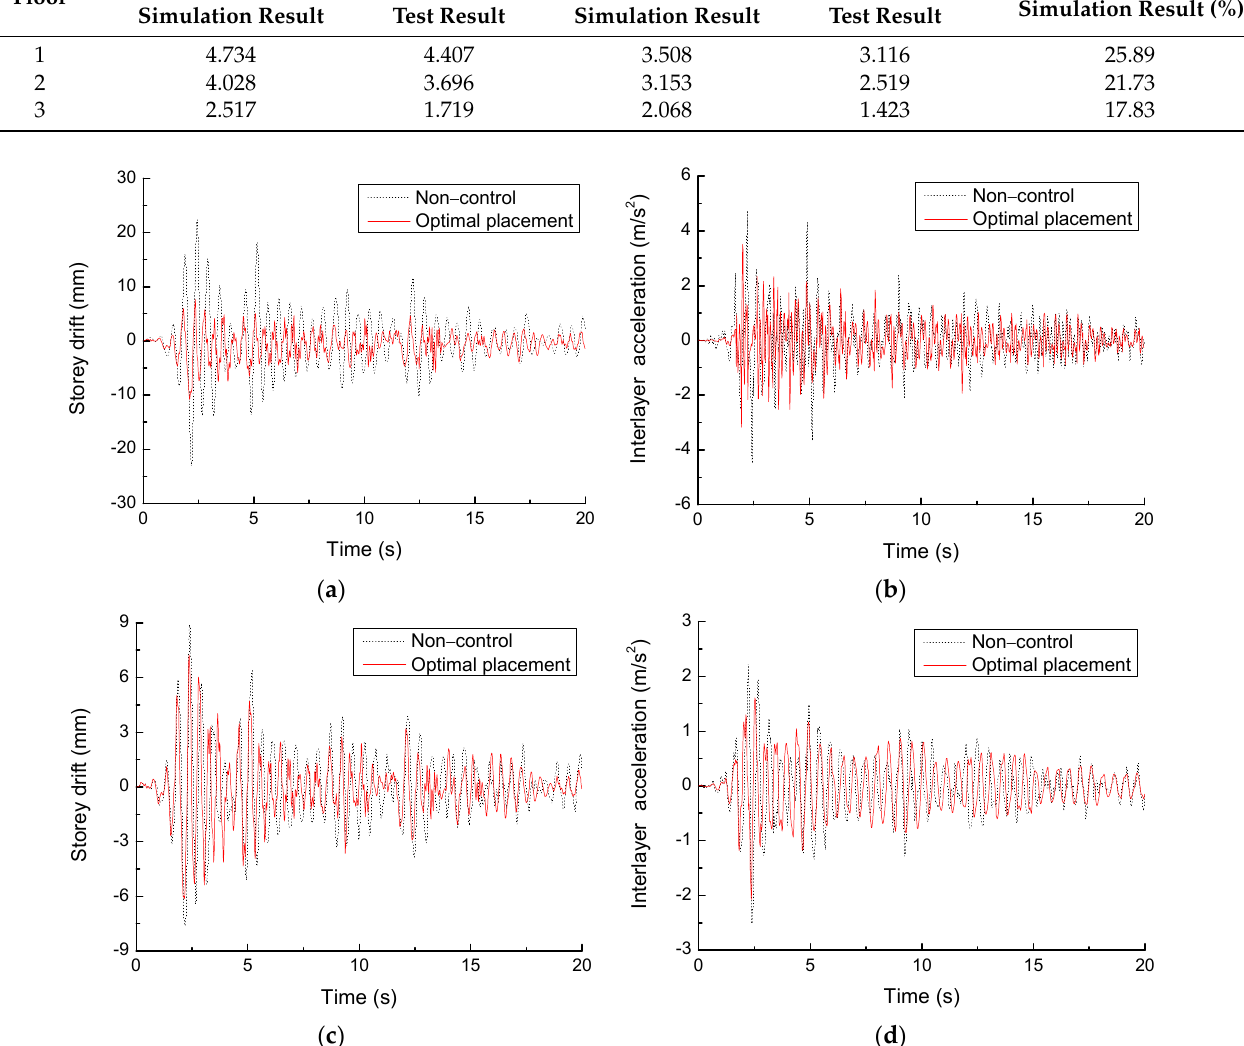
Figure 14. Time history curves of seismic response of spatial model structure with and without control, ( a ) storey drift of first floor, ( b ) interlayer acceleration of first floor, ( c ) storey drift of third floor, ( d ) interlayer acceleration of third floor.